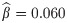
Kernel (a) and Cox (b, β^=0.060, p-value = 0.009) estimate of conditional hazard function with GTV as a covariate.